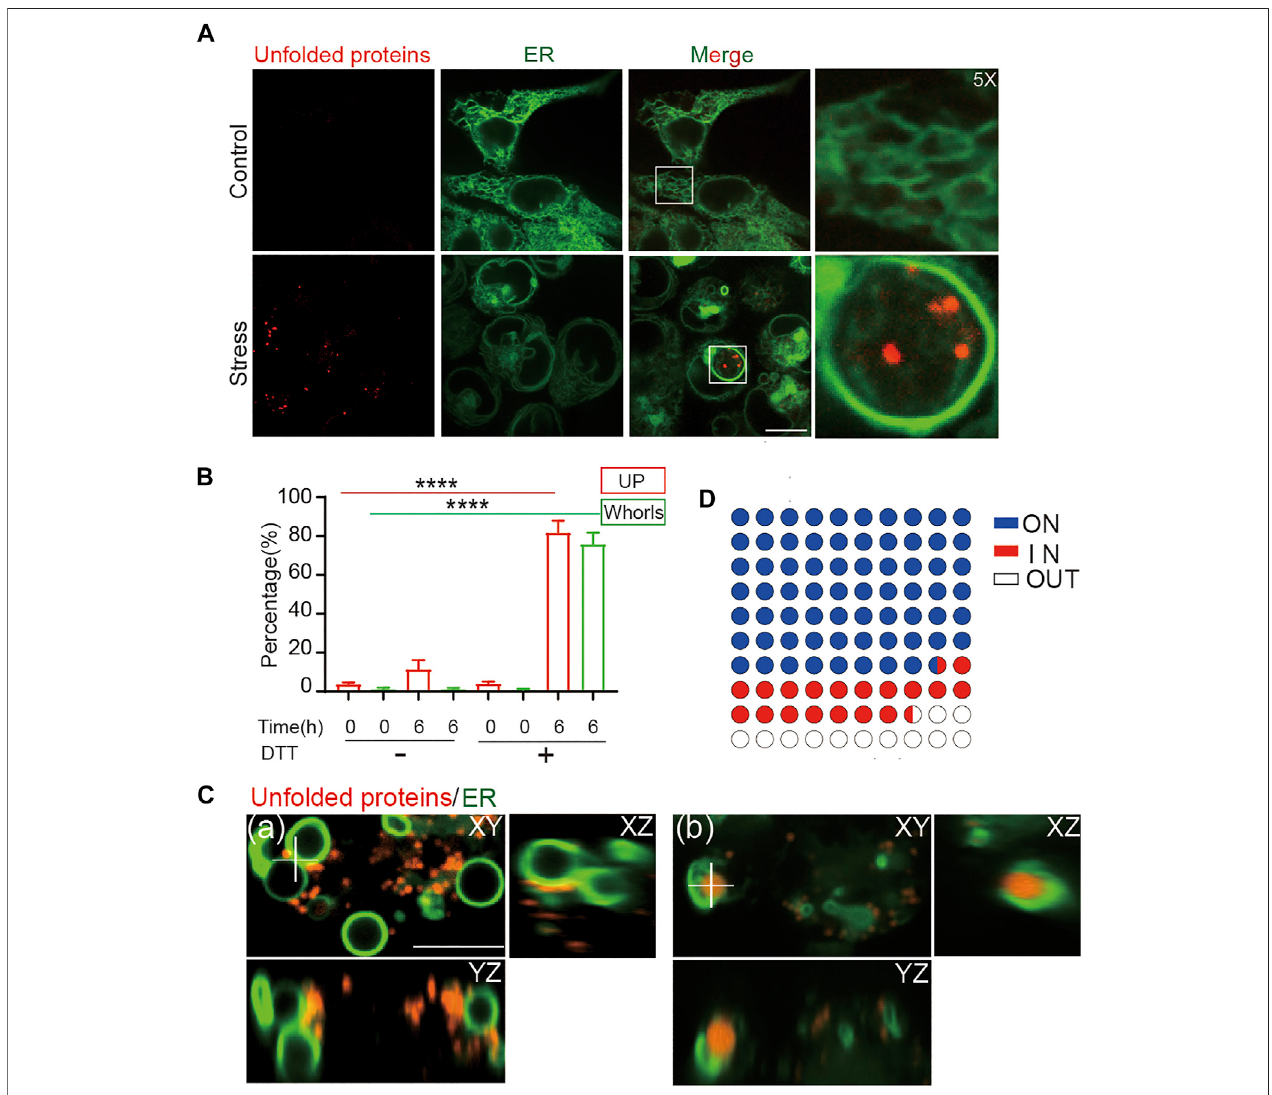
FIGURE 4 | ER whorls tether unfolded proteins under stress. (A) ER whorls and unfolded protein (UP) puncta appear only under stress. Scale bar (cid:1) 10 μ m. (B) Quanti fi cation of unfolded protein puncta and whorls under stress. A 6-h treatment of 10 mM DTT induced both unfolded protein and whorls formation at a fi nal ratio of 81.7 ± 2.1% and 75.7 ± 2.0% (mean ± SD; from n (cid:1) 235 cells), respectively. ****: p < 0.0001. (C) 3D view of colocalization of unfolded proteins and whorls. Unfolded proteins may be incontact withthe outside surfaces ofwhorls (a) or exist insidethe whorls (b). Scale bar (cid:1) 1 μ m. (D) Quanti fi cation oflocalizationofunfold proteins with respect to whorls, 68.3 ± 0.3% (mean ± SD; from n (cid:1) 355) of whorls have UPs attached to the membrane (ON), 19.3 ± 0.2% of whorls wrapped UPs inside (IN).